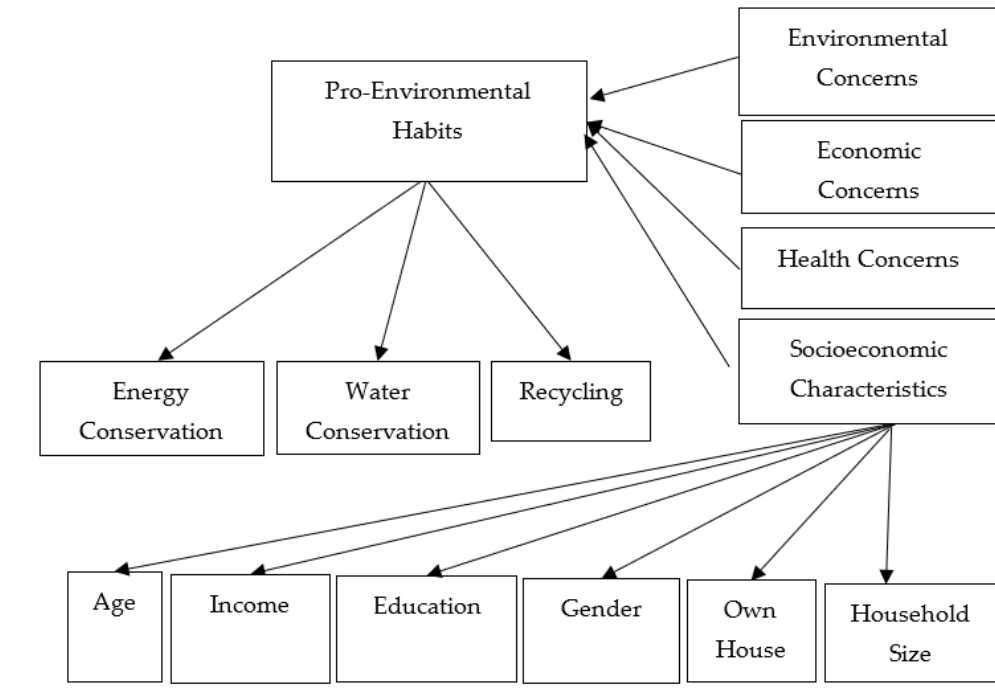
Figure 1. Research framework.